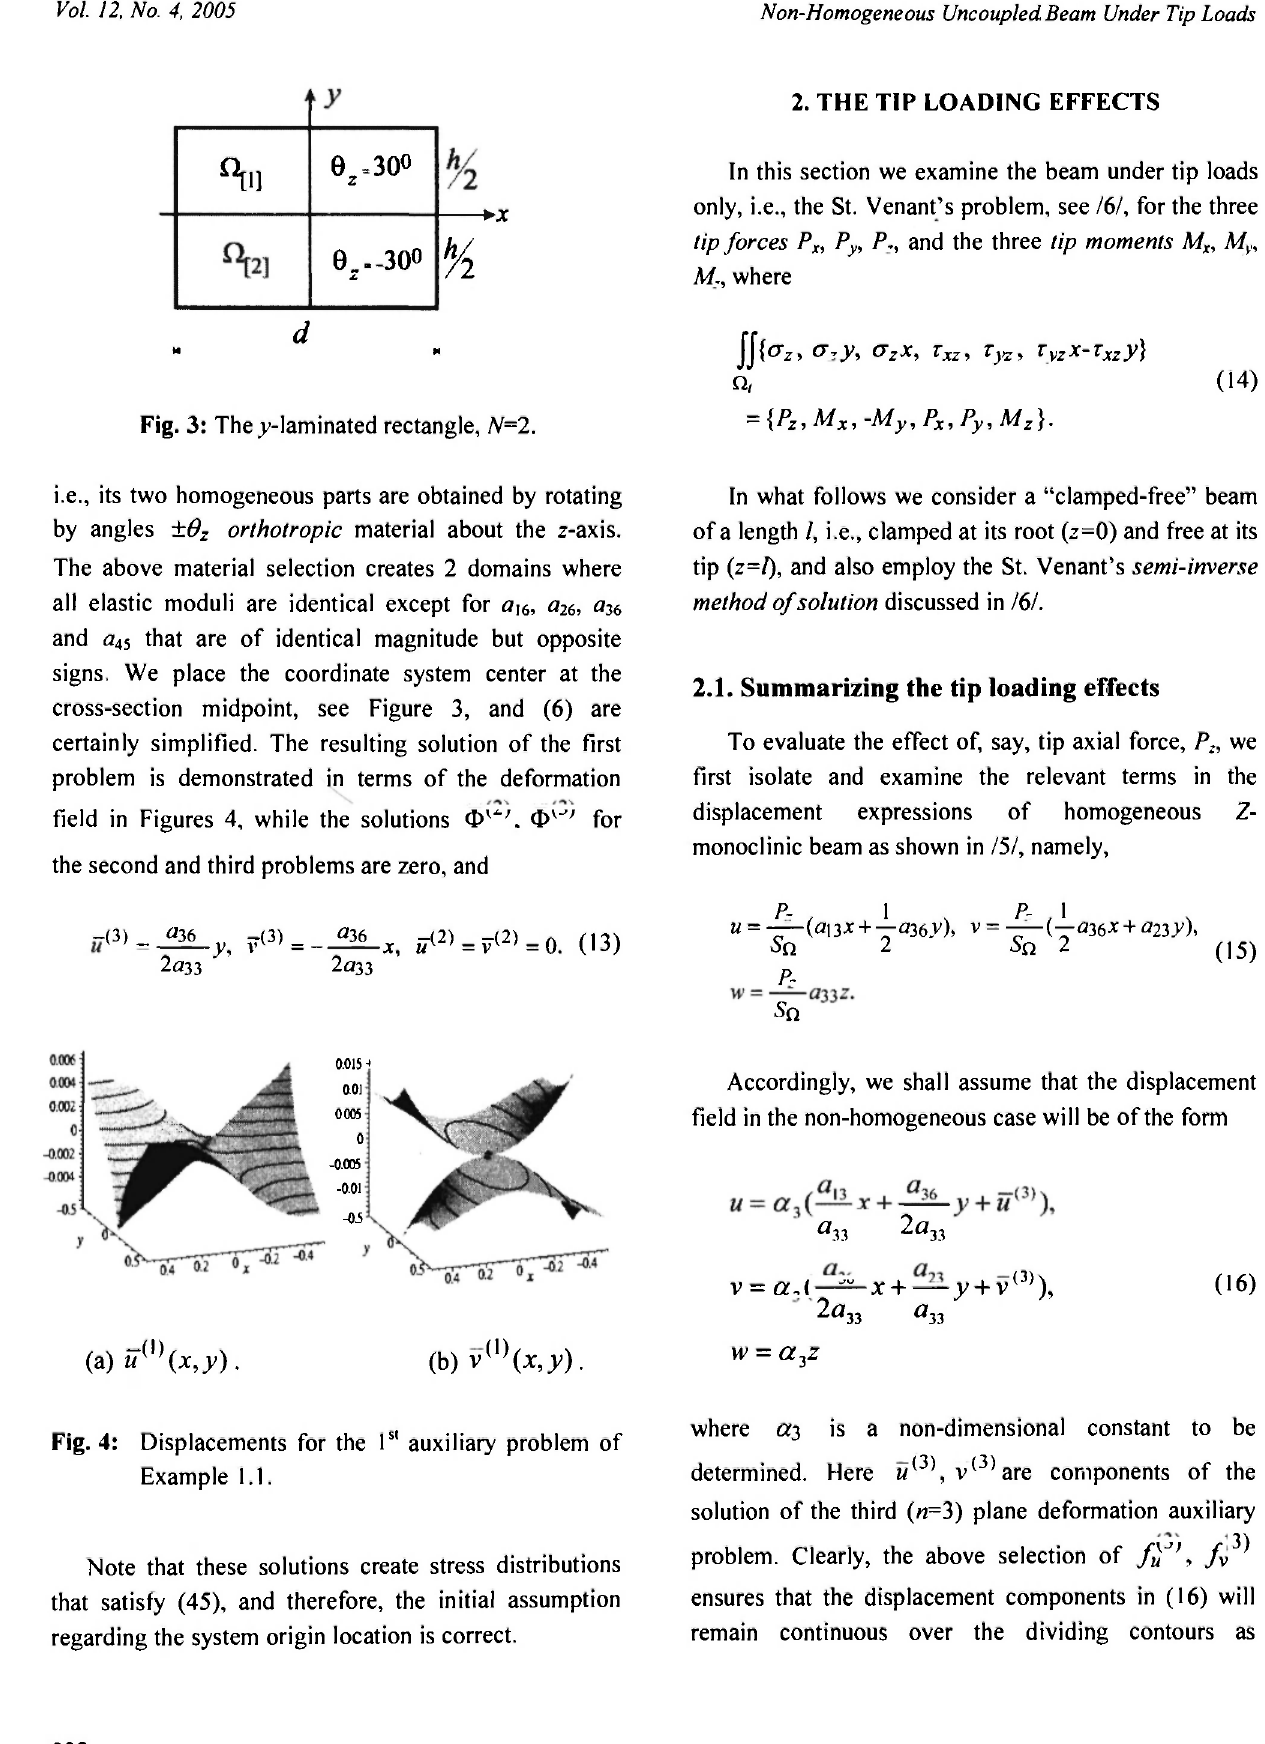
Fig. 4: Displacements for the 1 st auxiliary problem of Example